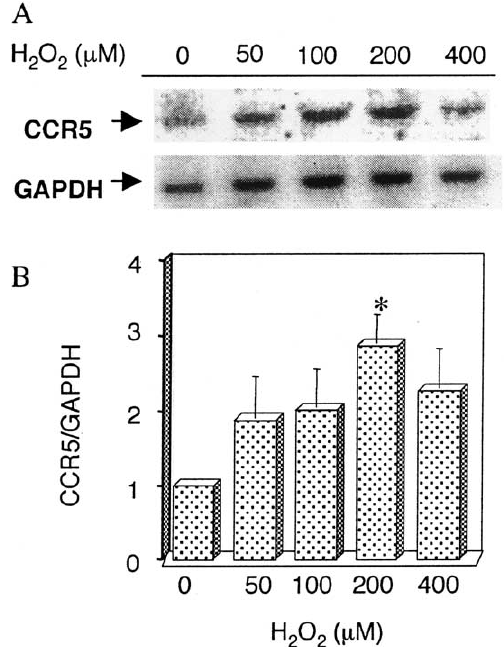
FIG. 2. Effect of H 2 O 2 on the expression of CXCR4 and PAFR mRNA in human monocytes. Human monocytes were incubated for 4 h with graded concentrations of H 2 O 2 in serum-free RPMI 1640 medium and total RNA was extracted and analysed by northern blotting for CXCR4 and PAFR mRNA expression. (A) Autoradiogram of northern blot hybridized with radiolabelled CXCR4 cDNA. The same membrane was rehybridized with radiolabelled PAFR (B) or GAPDH (C)